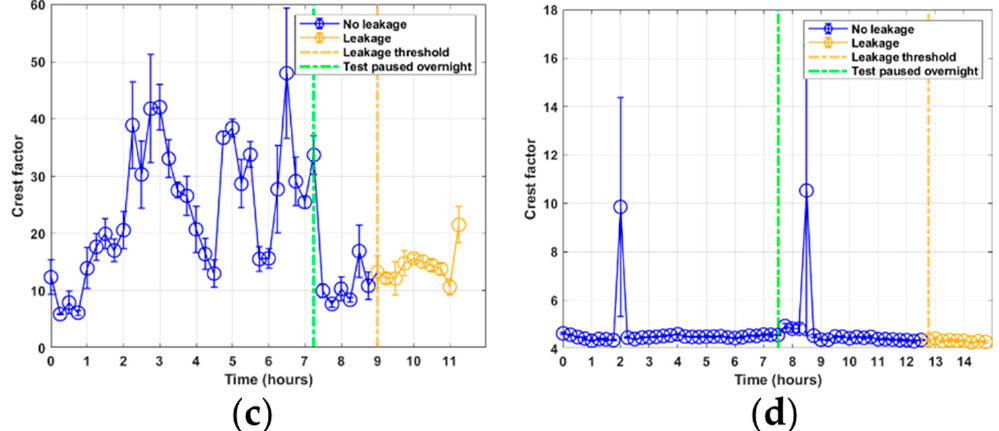
Figure 7. Crest factor feature results from RTF tests 1–4: ( a ) test 1; ( b ) test 2; ( c ) test 3; ( d ) test 4.